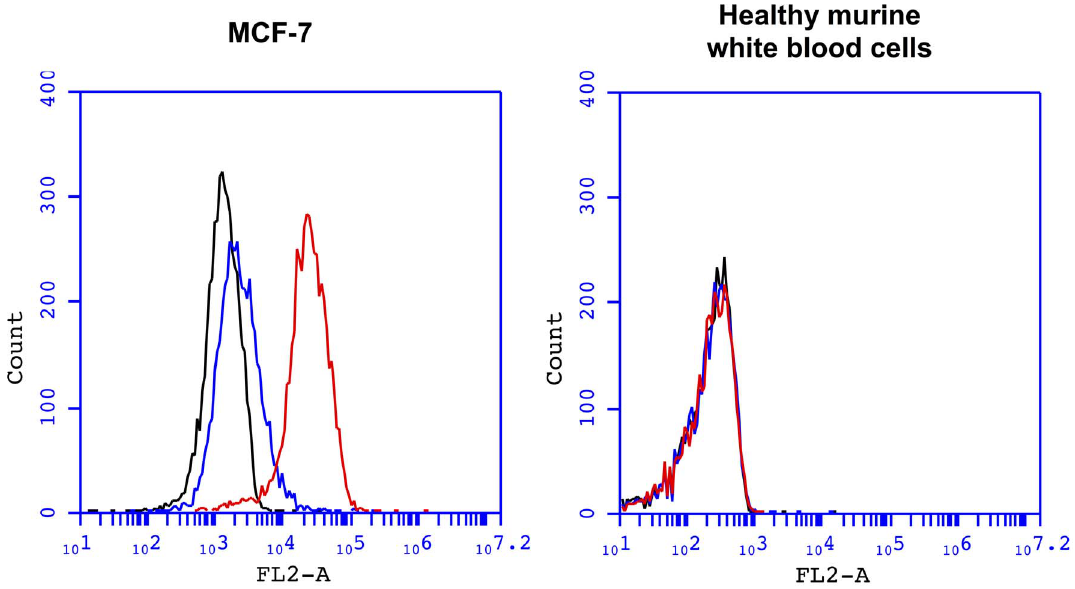
Figure 5. Comparison of the ACE4 aptamer binding on MCF-7 cancer cells and murine healthy white blood cells by flow cytometry. The binding of PE-labeled ACE4 aptamer or scramble sequence was measured by flow cytometry on MCF-7 cells and murine white blood cells (left and right panel, respectively). Black lines represent auto-fluorescence of cells, red lines represent the fluorescence of cells incubated with the PE- labeled ACE4 aptamer and blue lines represent the fluorescence of cells incubated with the PE-labeled scramble sequence. Counts represent the number of cells counted.